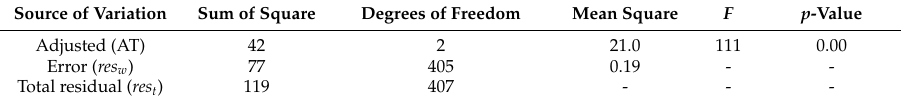
Table 11. Computation table for the cutting facilities based on chill casting method.